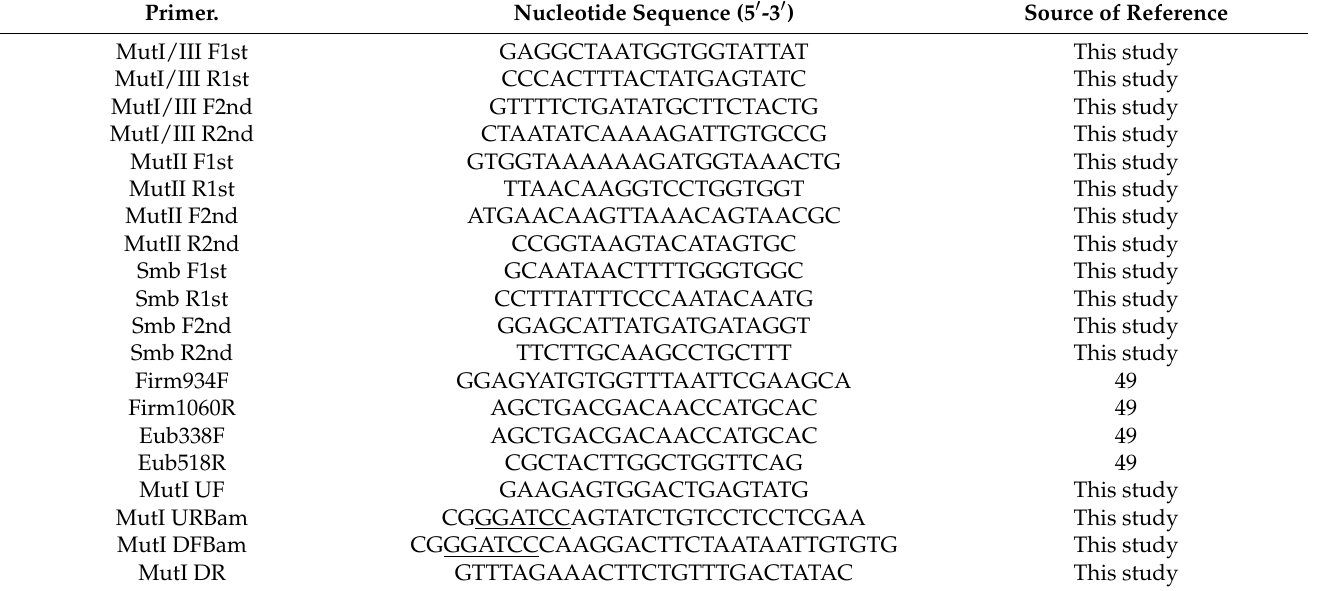
Table 1. Primers used in this